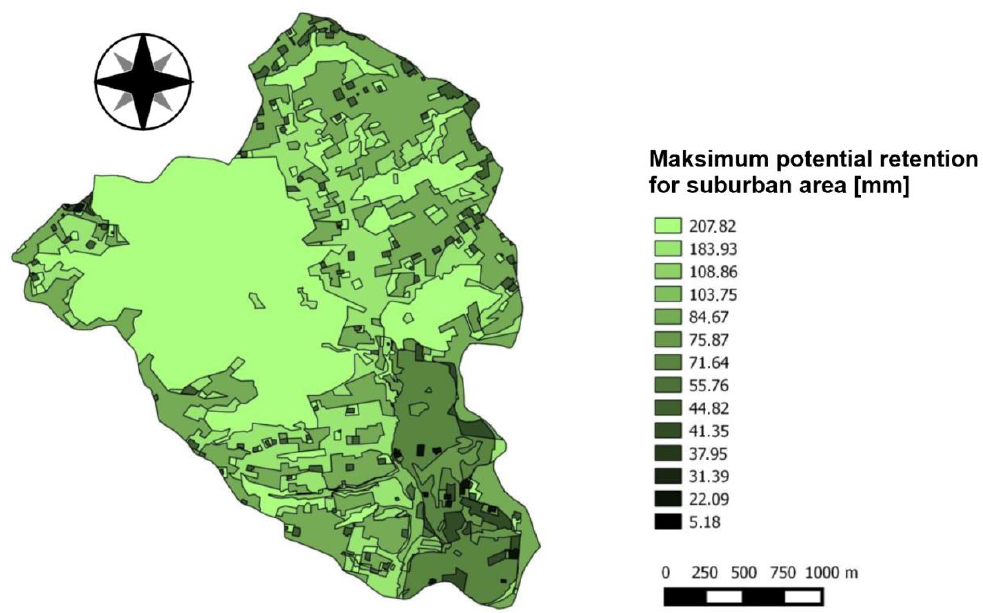
Figure 7. Maximum potential retention for suburban area.